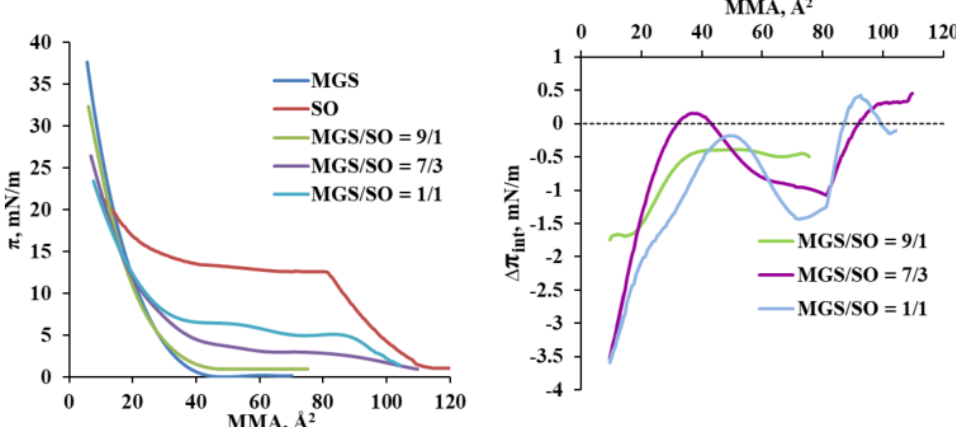
Figure 1. Left panel: Surface pressure ( π )/area (A) isotherms of MGS/SO pseudobinary films. The decrease of MGS content is compensated by a proportional increase of SO content in the film-forming solutions, so that the isotherms can be analyzed with Equation (1). Right panel: analysis of the MGS/SO interactions via application of Equation (1) to the π (A) isotherms of the pseudobinary films. The dashed line corresponds ∆π int = 0, i.e., ideal additive MGS/SO interactions. ∆π int < 0 and ∆π int > 0 show deviations from ideality, which in the context of the multilayer structure of the films indicate (i) aggregation of lipid molecules in thick surface domains or to (ii) the domains disaggregation at the interface respectively (see the main text for details).